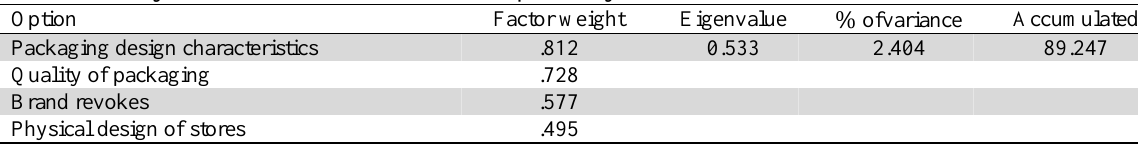
The summary of factors associated with compatibility Option